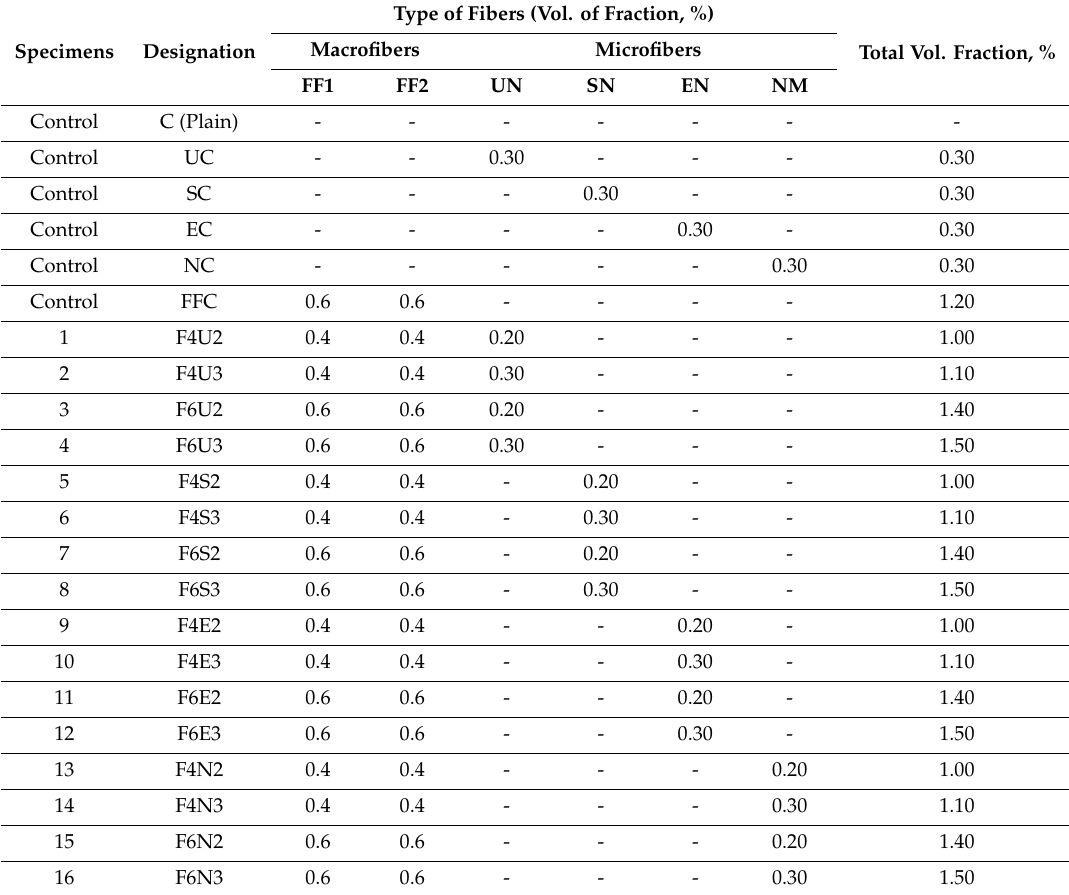
Table 2. HyFRC mix-design. (C: Control; U: Ultra-Net; S: Super-Net; E: Econo-Net; F: Ferro; Vol.: